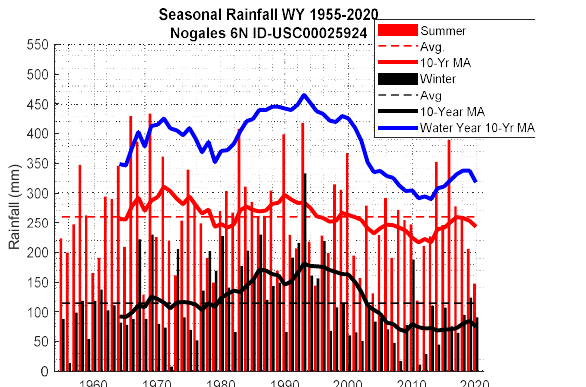
Figure 4. Observed summer (July–September) and winter (November–March) 1955–2020 precipitation (mm) from a rain gauge near Nogales, Arizona (USC00025924) and 1937–2020 streamflow (1000 m 3 ) on the Santa Cruz River near the border crossing from Sonora to Arizona (USGS-09480500). The inter-annual averages are indicated as horizontal solid lines. The seasonal and the water year (blue) 10-year moving averages are indicated as solid lines.